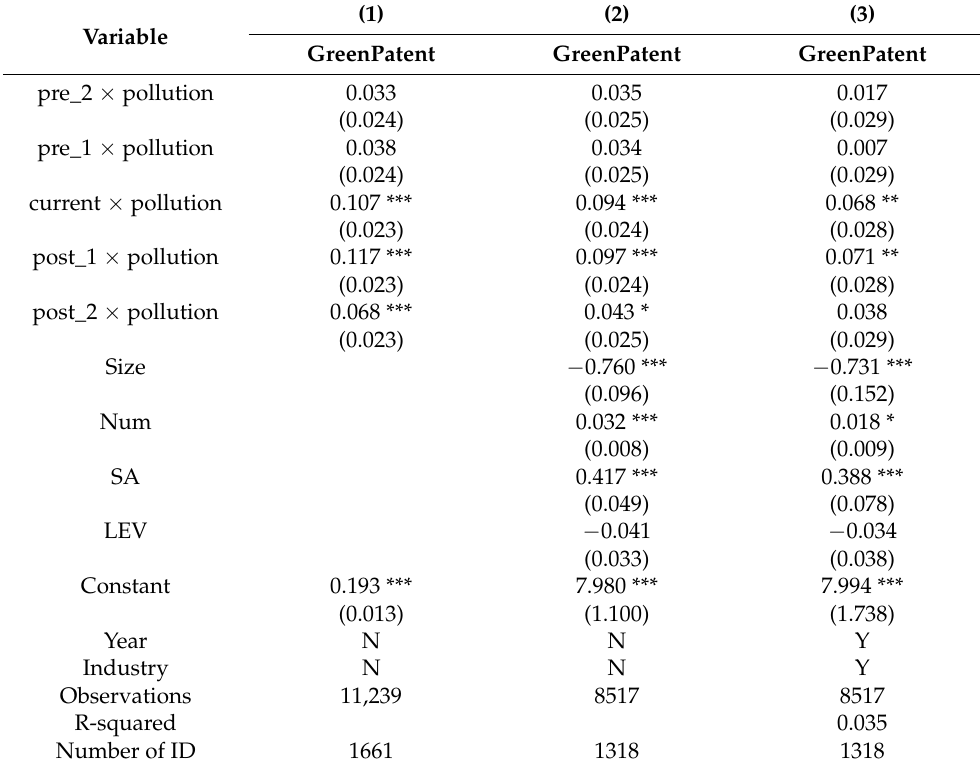
Table 4. Environmental regulation and corporate green innovation: dynamic